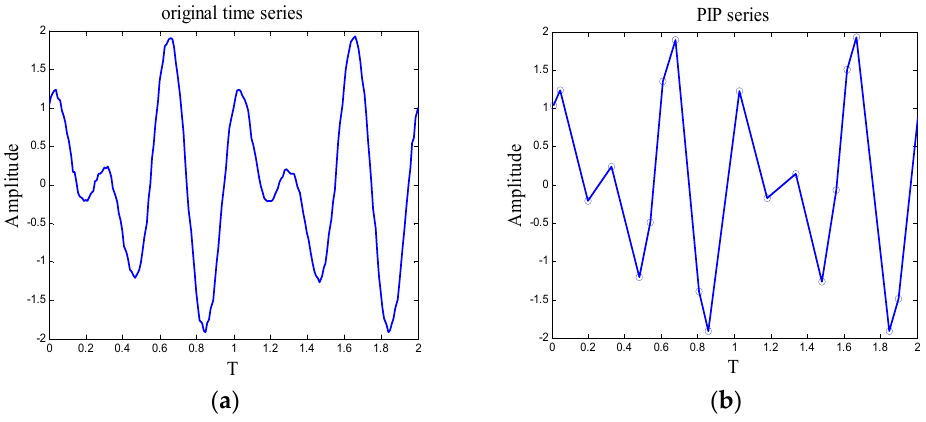
Figure 2. ( a ) Waveform of simulating signal; ( b ) Waveform of PIP series.